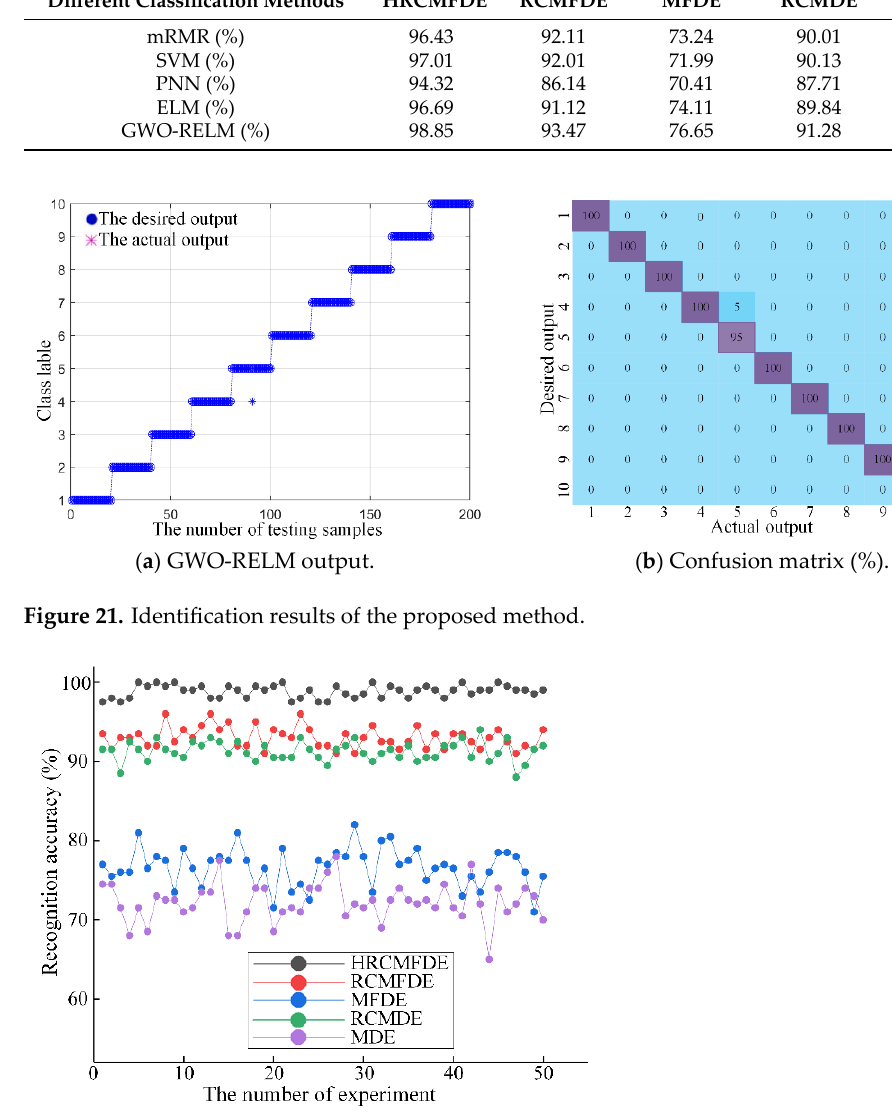
Figure 22. The accuracy of different feature extraction approaches.